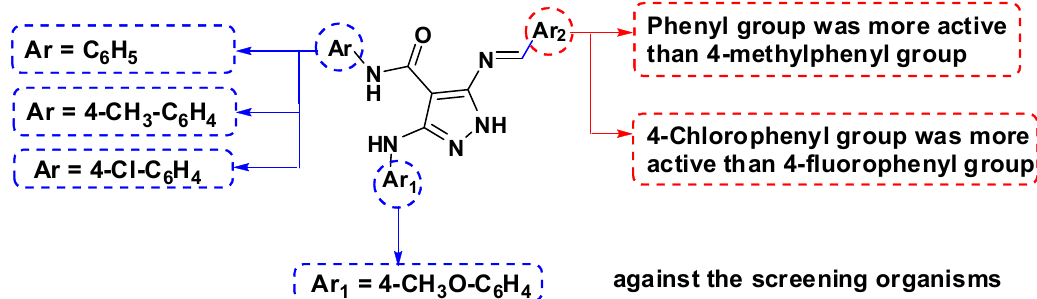
Figure 3. A brief Structure activity relationship (SAR) study of Schiff bases 14 – 25.